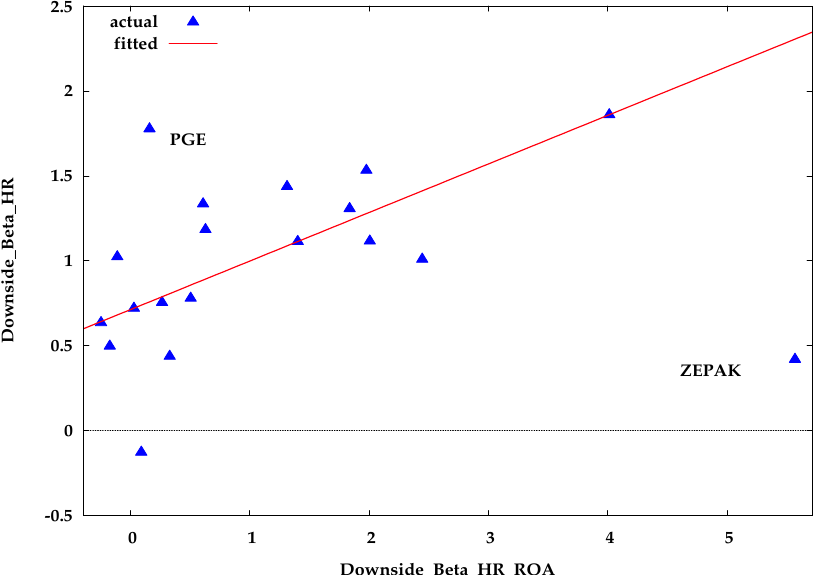
Figure 7. Quantile regression line for downside beta coefficient vs. downside beta coefficient for ROA ( 𝜏 = 0.5 ).